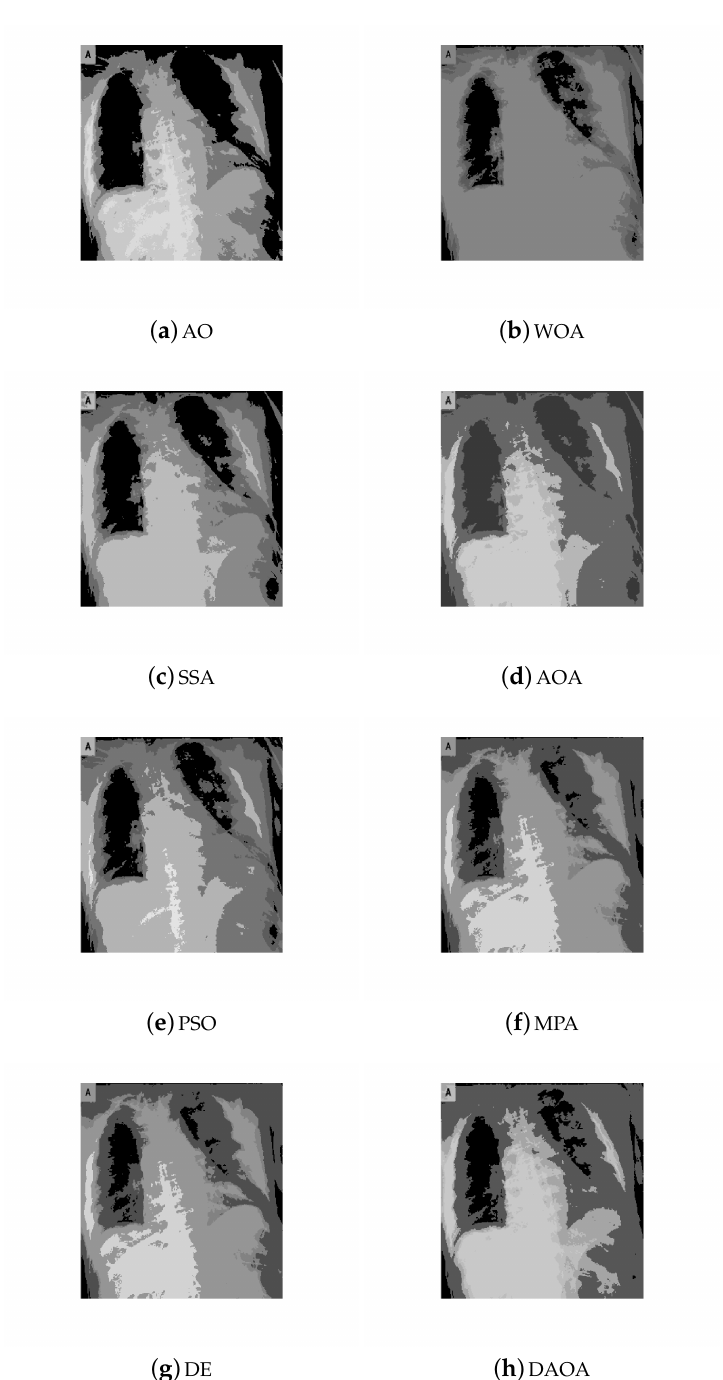
Figure 8. The segmented image (Test 8) by the comparative methods when the threshold value is